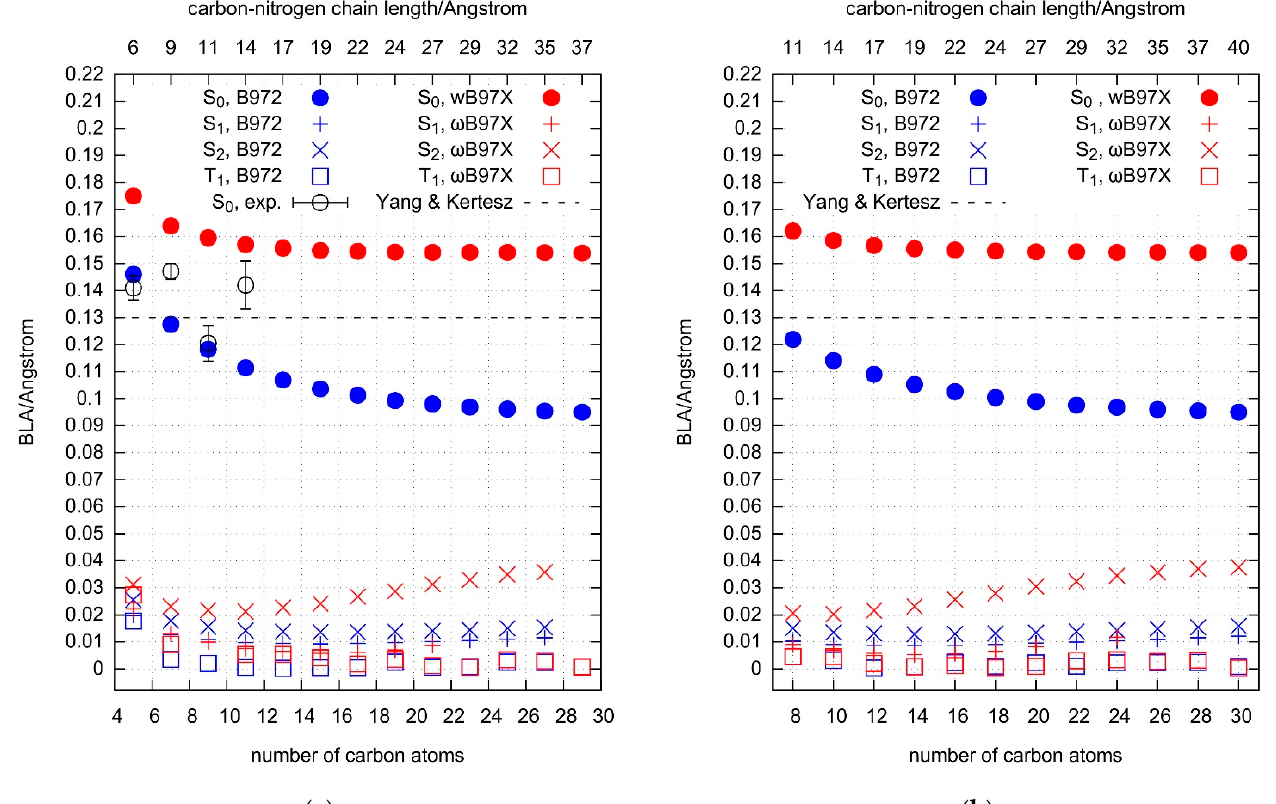
Figure 9. Bond length alternation plotted as a function of the number of carbon atoms in HC 2 n +1 N ( a ) and C 2 n +2 N 2 ( b ) families. The upper horizontal scale gives approximate lengths of the carbon- nitrogen chains. The black dash horizontal line represents the BLA value estimated for a long polyyne [64]. Experimental values (with 1 σ experimental uncertainty) are based on microwave spectroscopic measurements of the ground vibrational states [65].